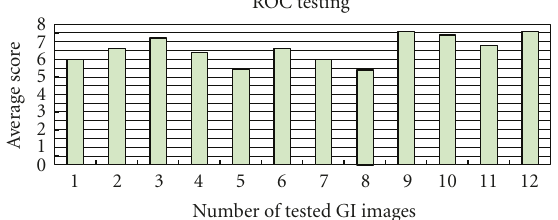
Figure 14: The evaluation results of professional gastroenterology doctors.